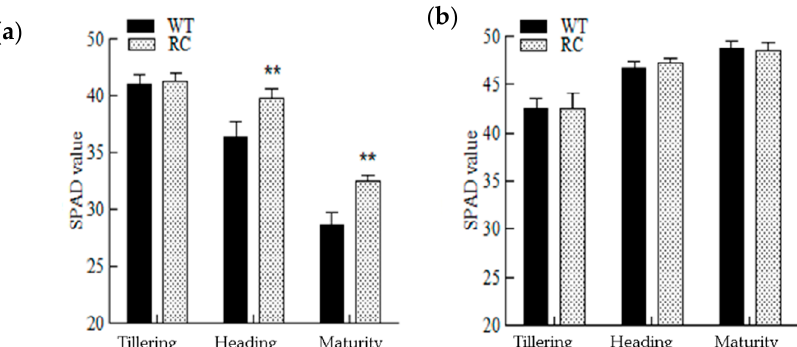
Figure 3. SPAD values of rice leaves at different growth stages under different treatments in pots: ( a ) No nitrogen treatment—LN; ( b ) normal nitrogen treatment—NN. ** Indicates significant difference ( p < 0.05) between different samples in the same growth period calculated by LSD’s test.